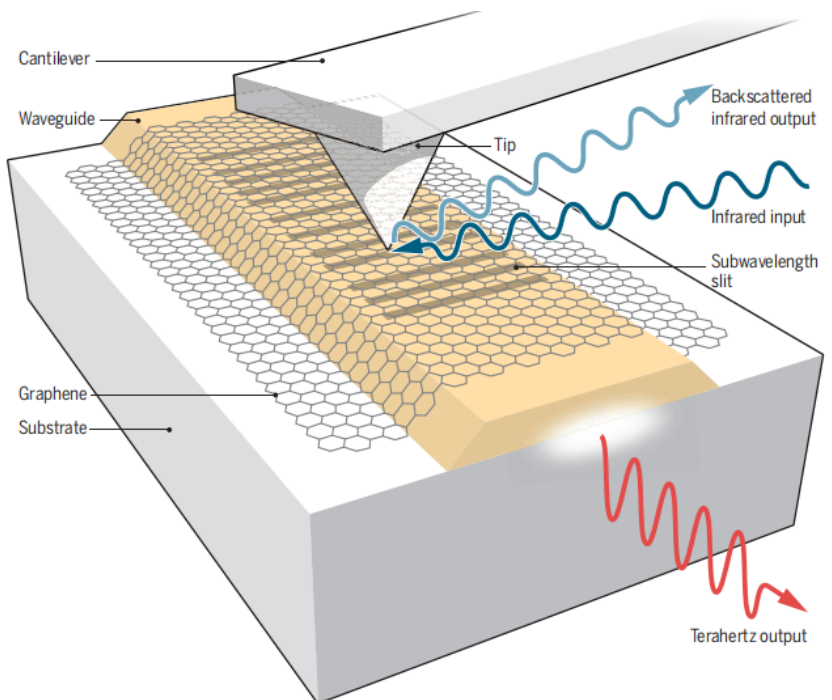
Figure 3. Probing plasmons in aperiodic lattice lasers. (Reproduced with permission from ref. [51]. Copyright 2016 American Association for the Advancement of Science Publications.).